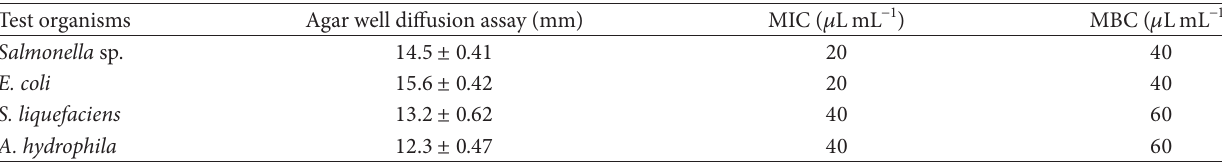
Table 1: In vitro antibacterial potential of biosynthesized Ag NPs using T. conoides extract against marine biofilm forming bacterial isolates. Test